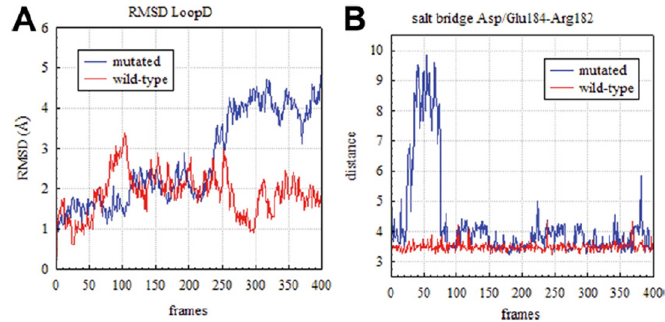
Figure 5. Effect of D 184 E mutation. ( A ) Root-mean-square deviations (RMSD) computed with respect to the 3GD8 crystal structure [21] for the C-alpha atoms belonging to the hAQP4 loop D for both mutated (blue line) and wild-type (red line) form; ( B ) Time-dependence of the distance between the center of mass of the oxygen atoms in the acidic side chain of residue at position 184 and the center of mass of the nitrogen atoms in the side chain of R182, adapted from reference [27]. Coordinates were saved every 3 ps (400 frames for a total simulation time equal to 1.2 ns).